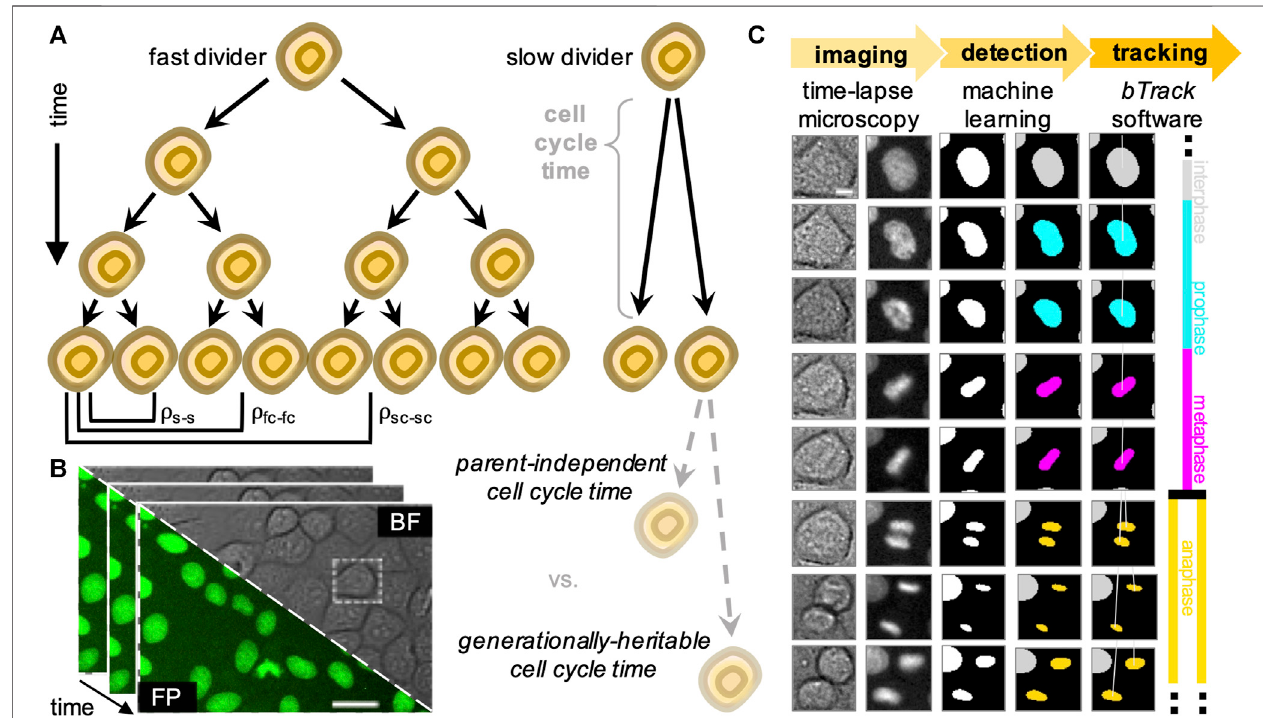
FIGURE1| Overviewoftheexperimental(dataacquisition)andcomputational(dataanalysis)designtotracksinglecellsandgeneratelineagetrees. (A) Weanalyse heritability of cell cycle duration across multiple cell generations using automatically reconstructed multi-generational lineage trees. (B) Sequential fi elds of view obtained by live-cell imaging experiments, showing both bright fi eld (BF) and fl uorescence (FP). Scale bar (cid:1) 20 μ m. (C) Fully automated, deep learning-based movie analysis consists of a cell detection step using information from bright- fi eld (col. 1) and fl uorescence (col. 2) time-lapse microscopy channels. Cells are localised using the segmentation network (col. 3) and labelled according to their mitotic state by a trained classi fi er (col. 4). Our software then performs multi-object tracking to reconstruct individual cell trajectories (col. 5) and assembles the parent-children relationships (col. 6) into lineage tree representations. Scale bar (cid:1) 5 μ m.